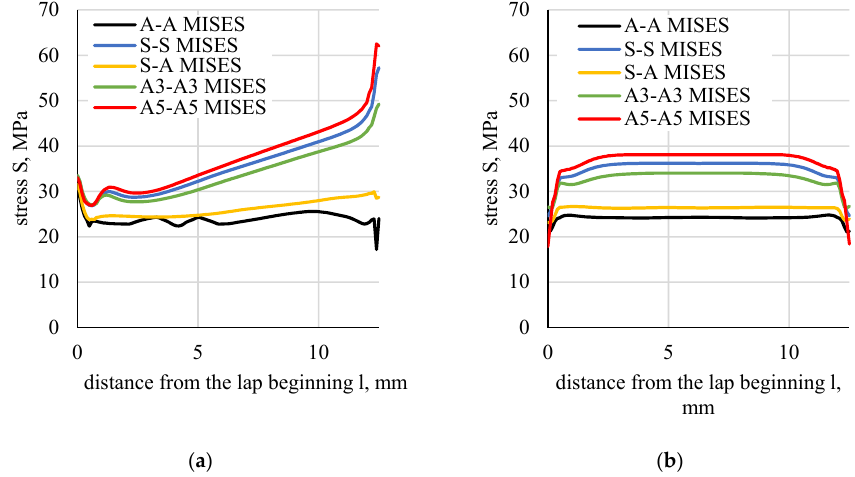
Figure 26. Distributions of shear stresses (S12): ( a ) in the boundary element–adhesive layer, ( b ) half length of the adhesive thickness.